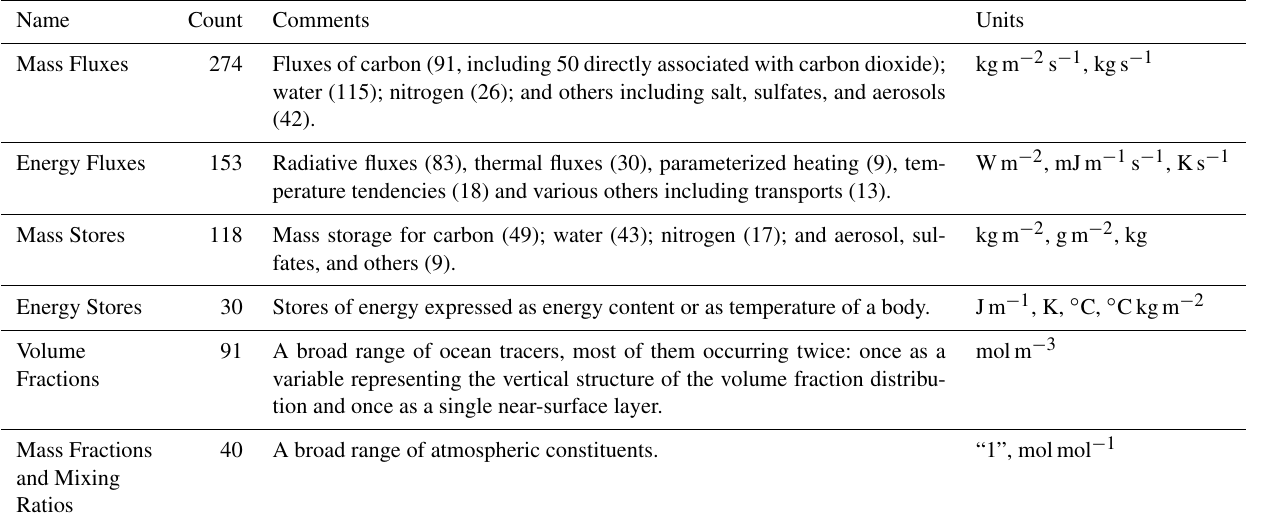
Table 1. Categories of DREQ variables. The second column shows the number of DREQ MIP variables which fall into each category. These six categories account for over 50% of the variables in